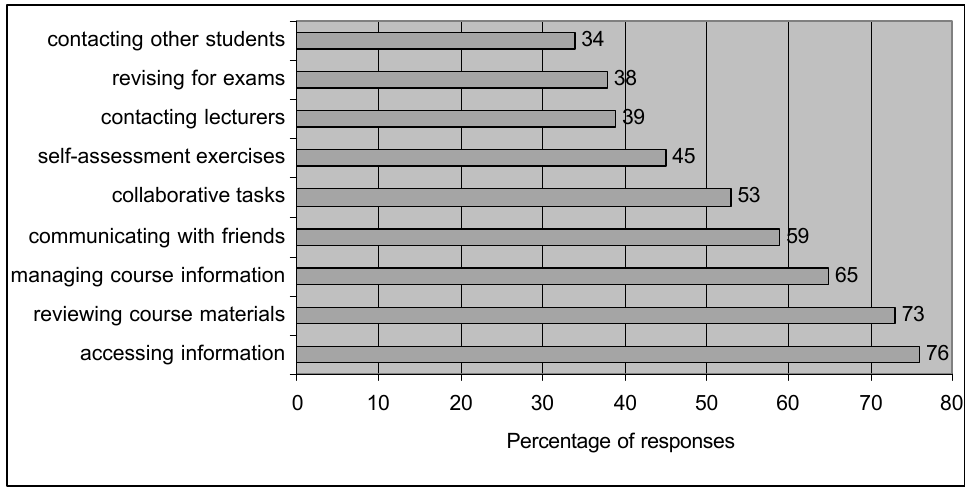
Figure 1. Summary of student responses on technology uses for self-directed